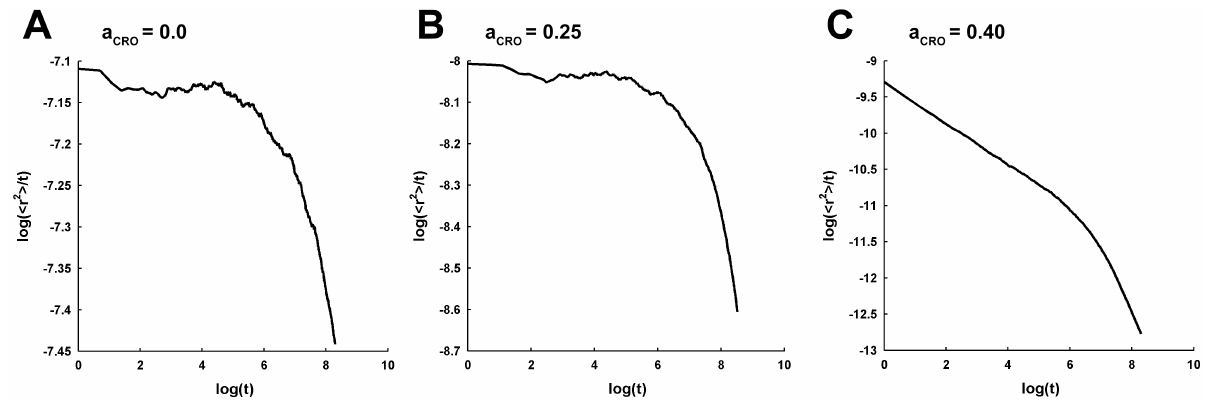
Fig 5. Log-log profiles of the MSD under the self-crowding condition with a DT = 0.001 for an extended duration of 4000ms. The log-log profiles are shown for the select few a CRO = 0.0 (A), 0.25 (B) and 0.40 (C). It is evident that the profiles exhibit sharp decay at longer time, which was not clearly noticeable in the log-log profiles for the time duration of 2000 ms shown in Fig 3D.